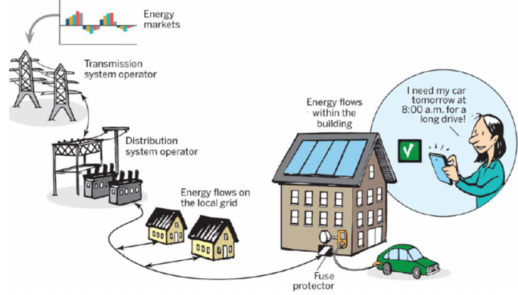
Figure 1. The elements of smart